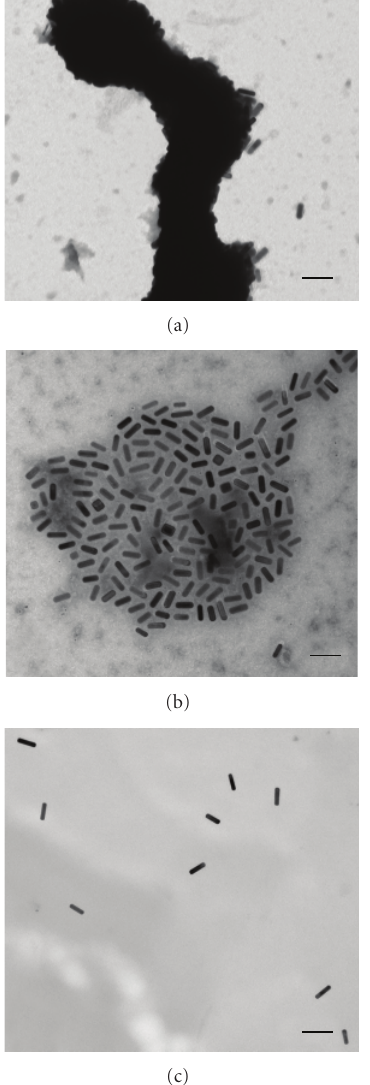
Figure 2: TEM images of nanorod conjugation to antibody before PEGylation versus PEGylated nanorod conjugation to antibody. (a) Nanorods first conjugated to anti-EGFR antibody then PEGy- lated; (b) Nanorods first PEGylated then conjugated to anti-EGFR antibody; (c) PEGylated nanorods without antibody or crosslinker present. All scale bars shown are 100nm.